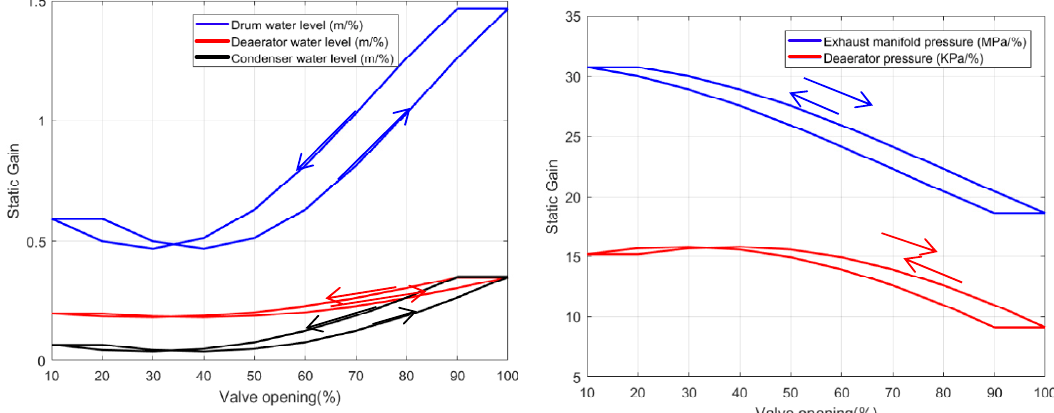
Figure 3. Static gain under different input changes. (The figures on left hand indicate the static gain for drum water level loop, deaerator water level loop, and condenser water level loop; and on the right hand indicate the static gain for deaerator pressure loop, and exhaust manifold pressure loop).